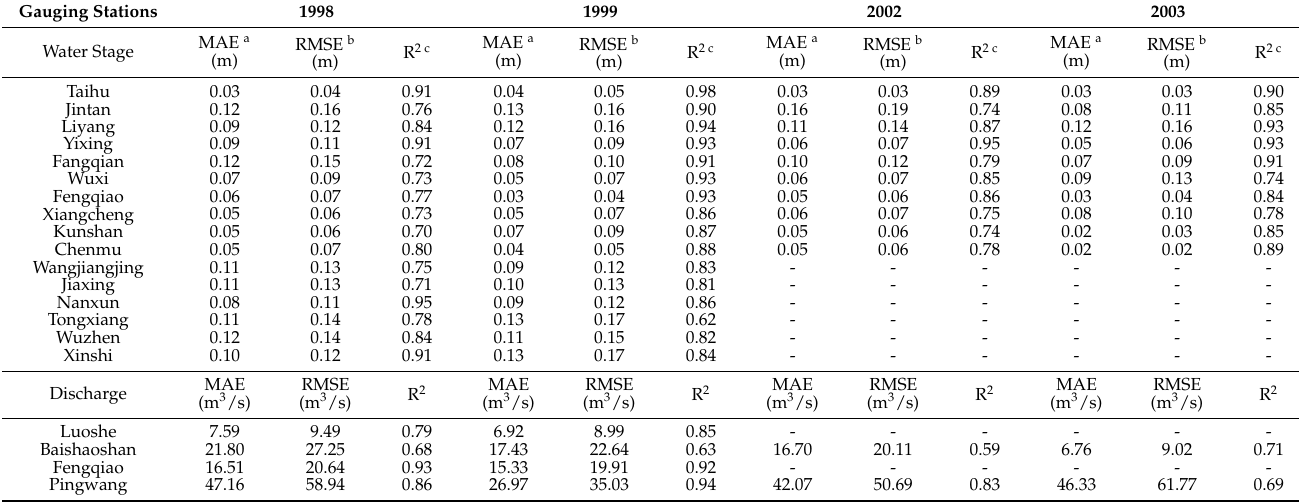
Figure 10. The comparison of simulated and observed discharge in Luoshe, Baishaoshan, Fengqiao, and Pingwang in 2000. Table 5. Statistical error parameters of simulated and observed water surface elevation (m) and discharge (m 3 /s) in 2000 for Taihu Lake and typical sites. Gauging